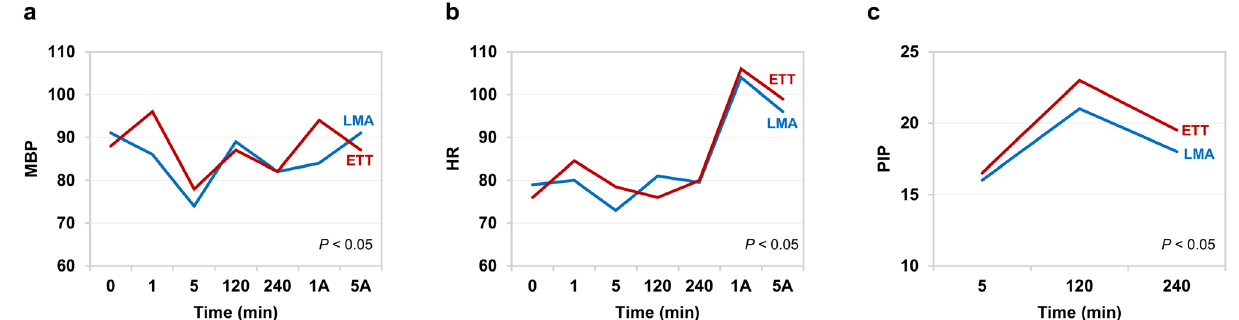
Figure 2. The change in variables over time in both groups. ( a ) The change in mean arterial blood pressure (MBP) over time. ( b ) The change in heart rate (HR) over time. ( c ) The change in peak inspiratory pressure (PIP) over time. LMA group LMA, ETT group ETT, 1A 1 min after airway device removal, 5A 5 min after airway device